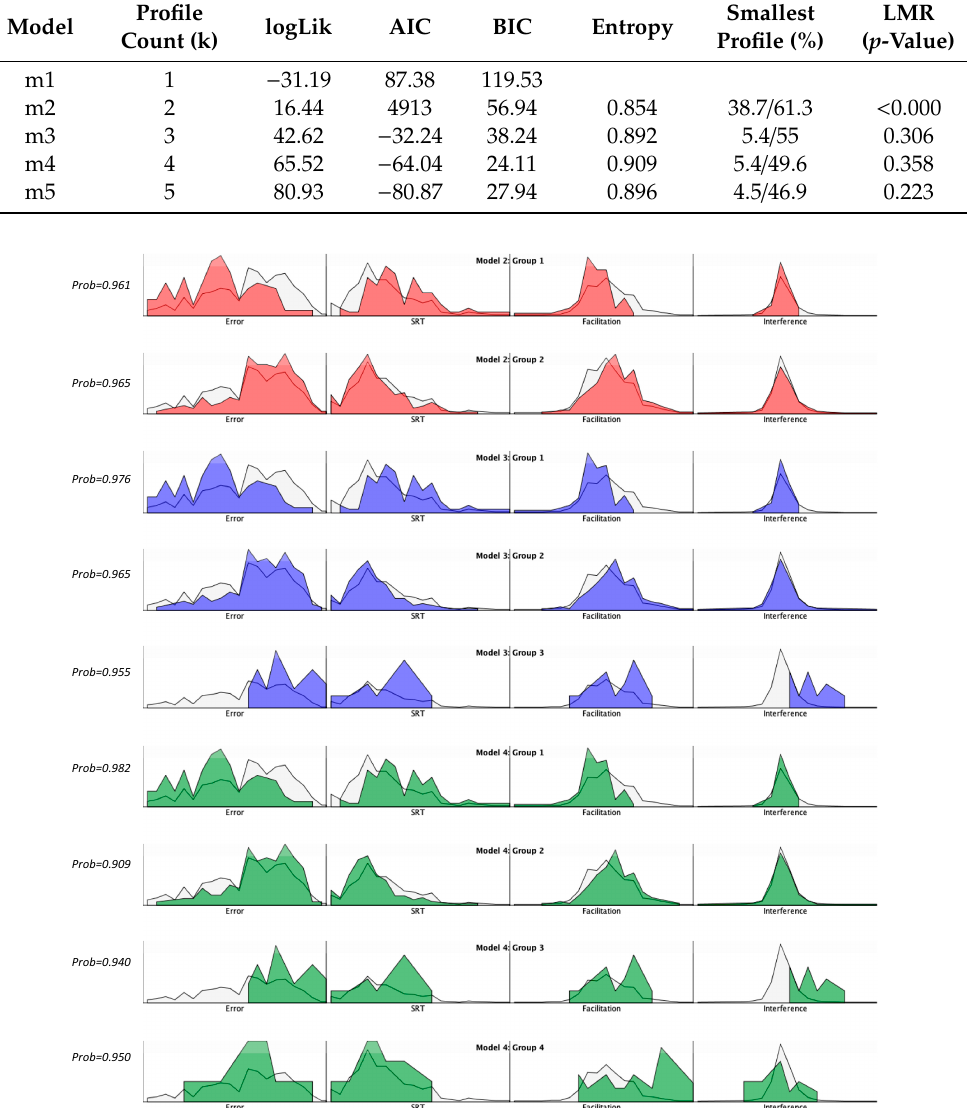
Figure 3. Frequency histograms for Models 2–4 as a function of latent profile group. Percent counts in color overaII means in light grey. The four IOWA task performance variables include task error (Error), saccadic reaction time (SRT), cue facilitation (Facilitation), and cue interference (Interference). Posterior probabilities for classification (Prob) indicated to the left or each group.